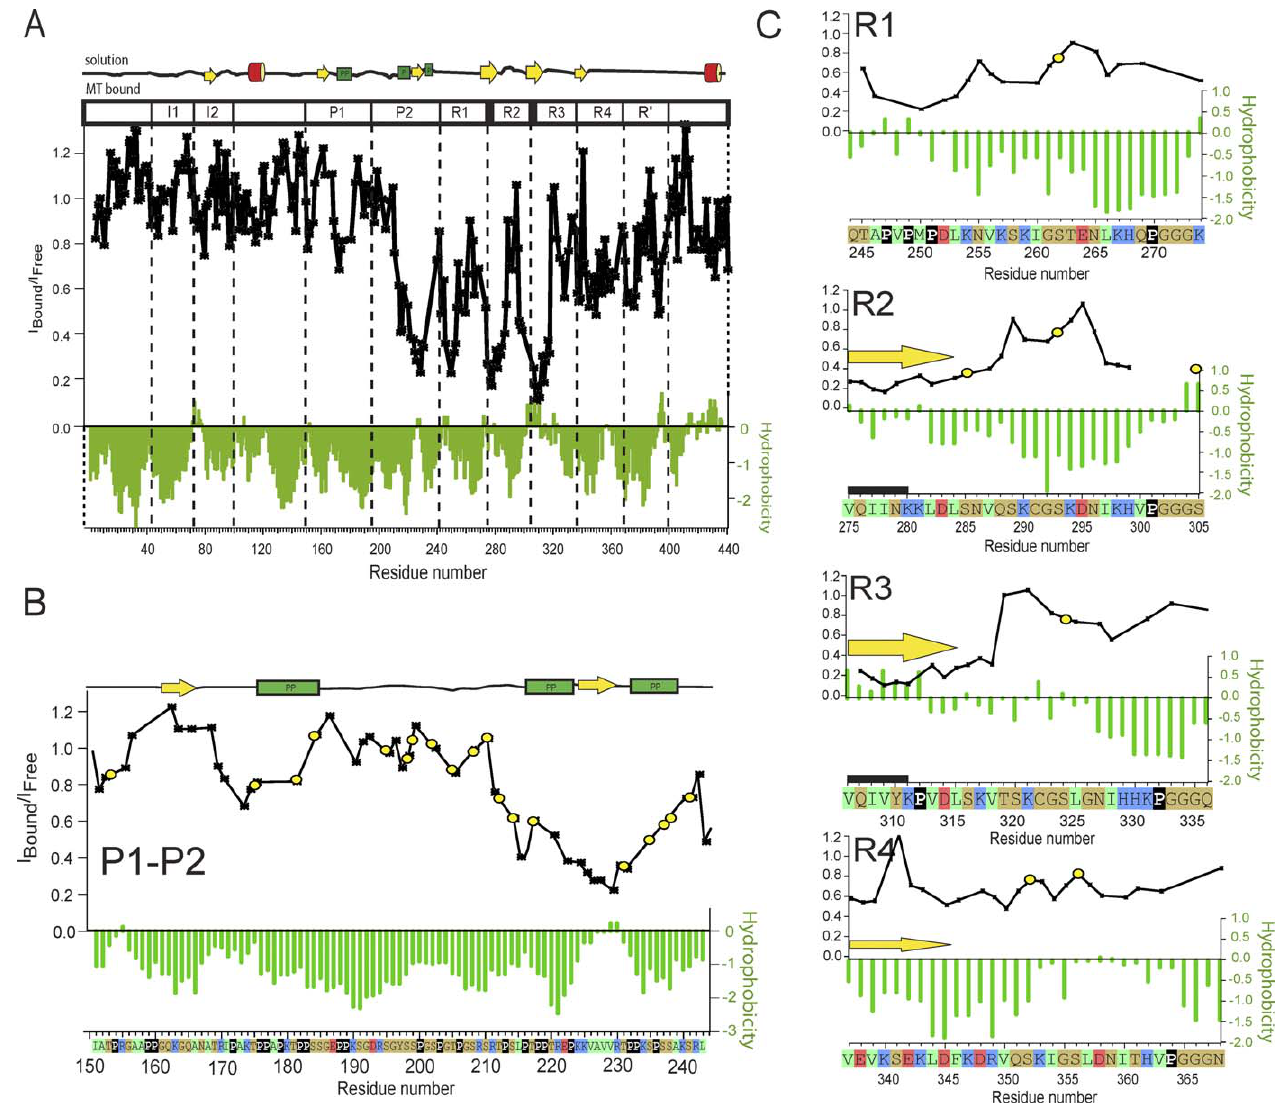
Figure 11. Comparison of MT-Binding Profile with Hydrophobicity Pattern of Tau (A) NMR signal intensity ratios between signals observed for htau40 in the MT-bound and in the free state (see also Figure 10B) are shown as stars and connected by lines. Hydrophobicity values calculated according to the Kyte-Doolittle scale are shown as green bars. Hydrophobic regions have positive or small negative hydrophobicity values. The location of transient secondary structure observed in unbound htau40 (i.e., as monomer in solution) is indicated as schematic on top. In (B) and (C) the regions that are important for interaction with MTs are shown in detail. The amino acid sequence is shown below. It is colour coded according to Figure 1B. The regions of tau that transiently populate b -structure and polyproline II helix in the unbound state are marked by yellow arrows and green bars. Phosphorylation sites are marked by yellow circles.